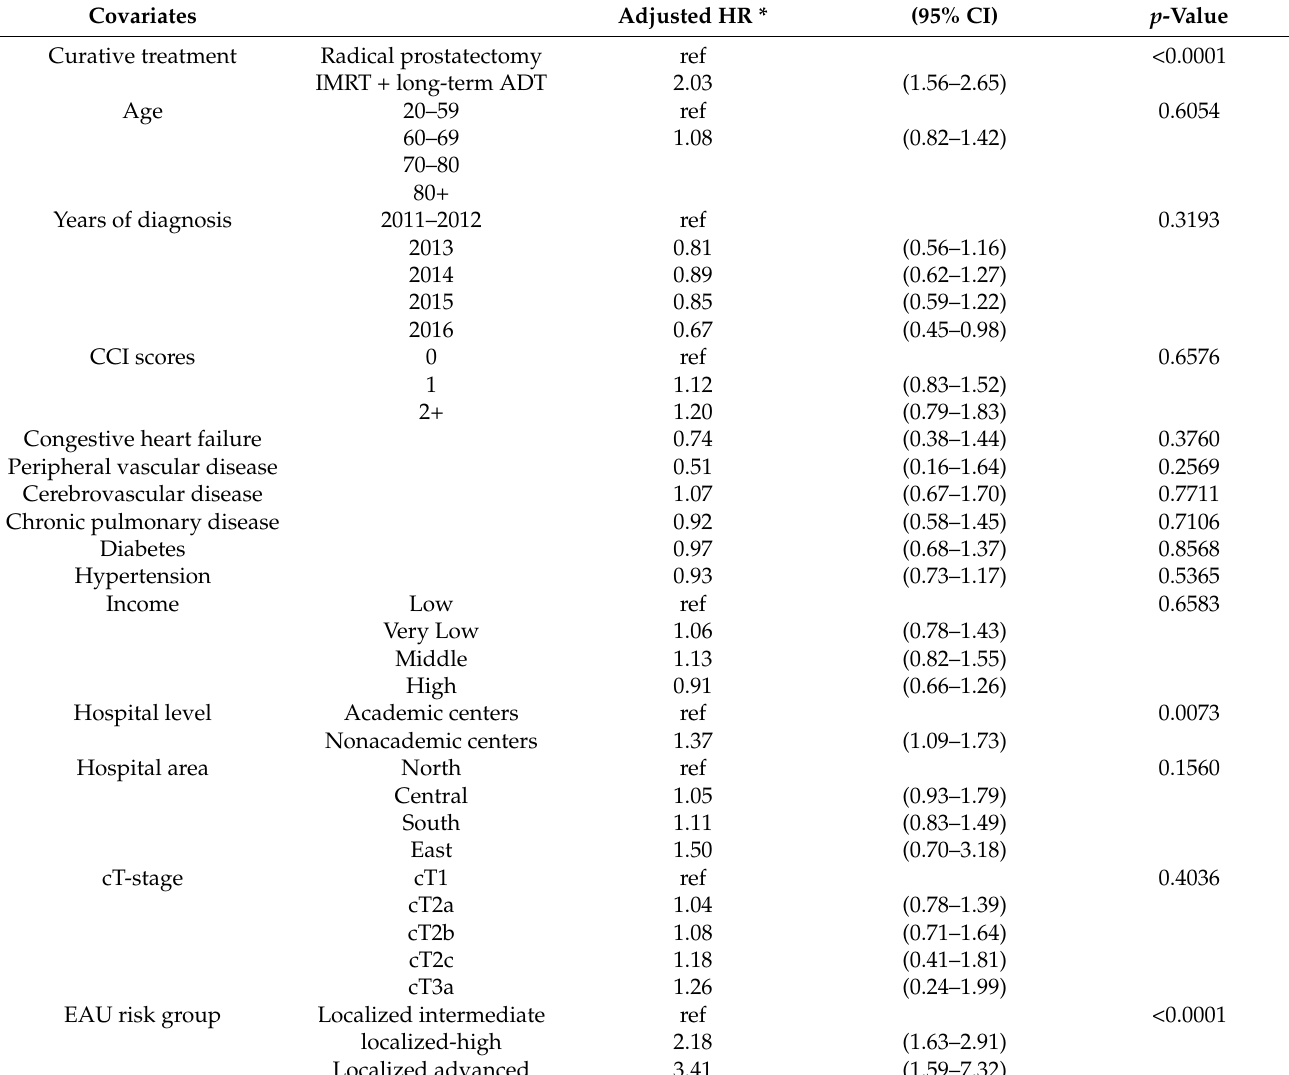
Table 3. Multivariate Cox proportional hazards regression analysis of biochemical recurrence in young patients with high- to very high-risk of prostate adenocarcinoma.